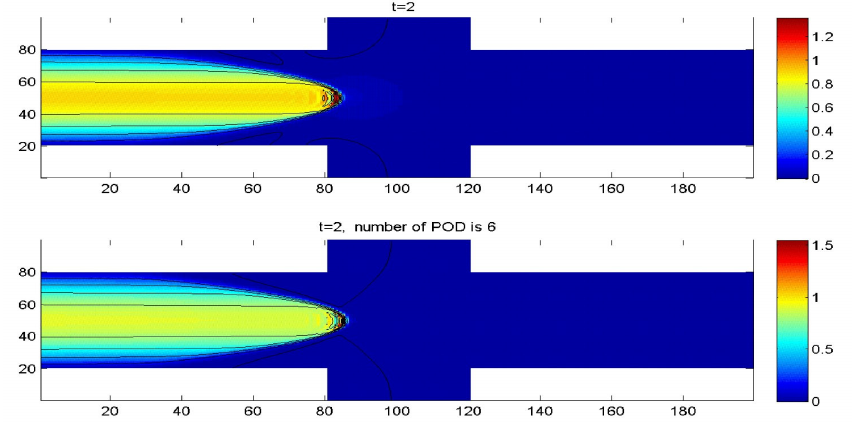
Figure 2. Top chart is the classical SCNMFE solution of velocity u and bottom chart is the POD-based reduced-order SCNMFE solution of velocity u with 6 POD bases when Re = 1000 and Pr = 7 at time t = 2.